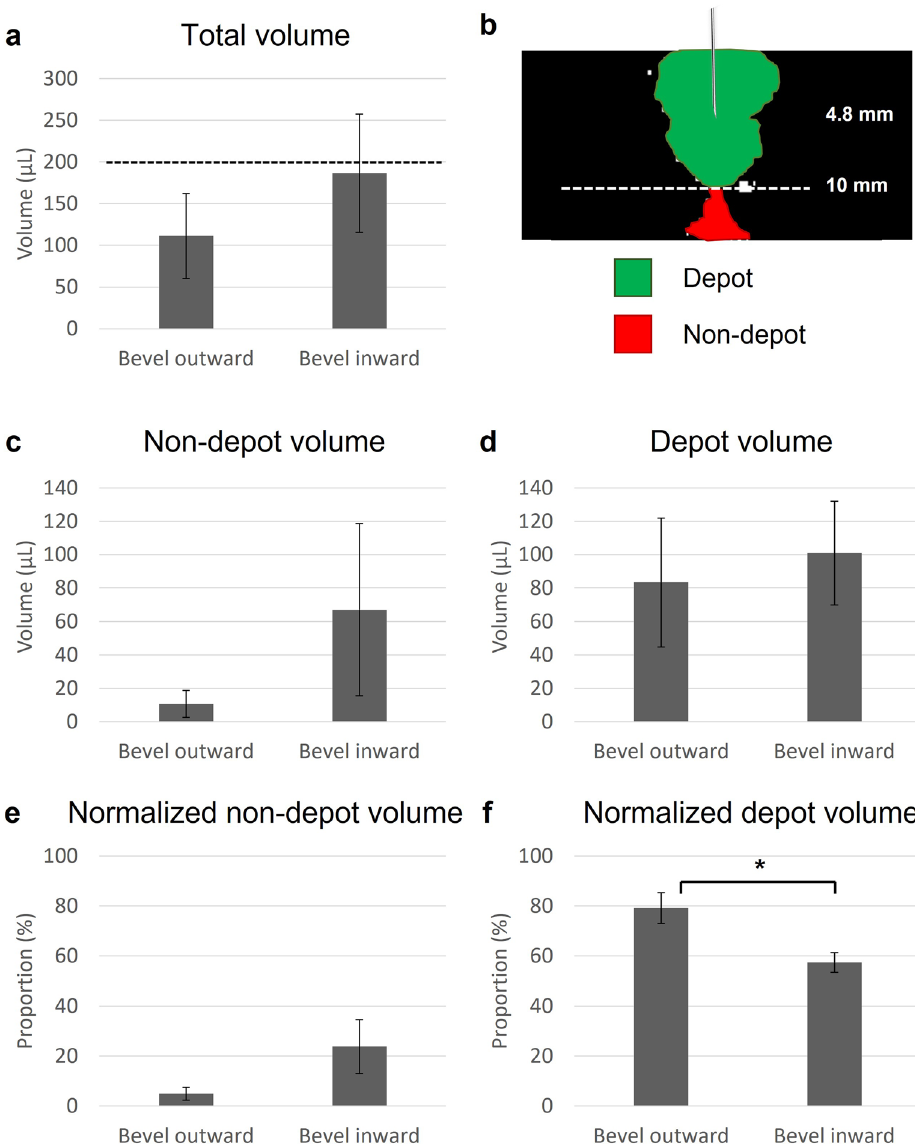
Figure 3. Variation across ex vivo swine injections (7.6 mm insertion depth, 10 mm/s insertion rate, 6% EC-ethanol, 10 mL/h infusion rate, 200 µL infusion volume). For half of the injections, the needle bevel was facing outward (towards the outer edge of the cervix), and for the other half, the needle bevel was facing inward (towards the os). To assess the amount of fluid localized at the needle tip, first ( a ) total distribution volume was calculated. The programmed infusion volume of 200 µL is indicated by the dotted black line. ( b ) Then, fluid was segmented into ( c ) depot volume, which was defined as the largest region around the needle tip in the top 10 mm of the tissue, and ( d ) non-depot volume, which was defined as the fluid below 10 mm into the tissue. ( e ) The normalized non-depot volume (non-depot volume/total distribution volume) quantified to proportion of fluid outside of the depot (in cracks). ( f ) The normalized depot volume (depot volume/total distribution volume) quantified the proportion of fluid within the depot (around the needle). As seen, normalized depot volume was significantly higher when the bevel was facing outward, likely because there was less leakage into the os. All groups had a sample size of n = 4 to 5. *p <